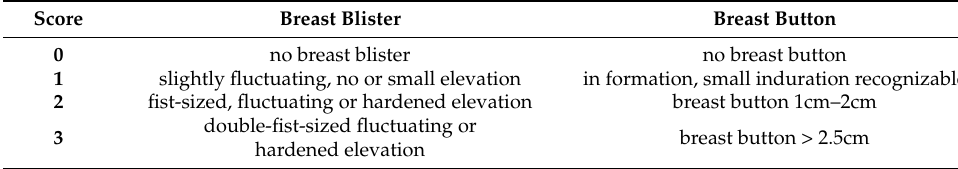
Table A6. Scoring of the breast skin [26].